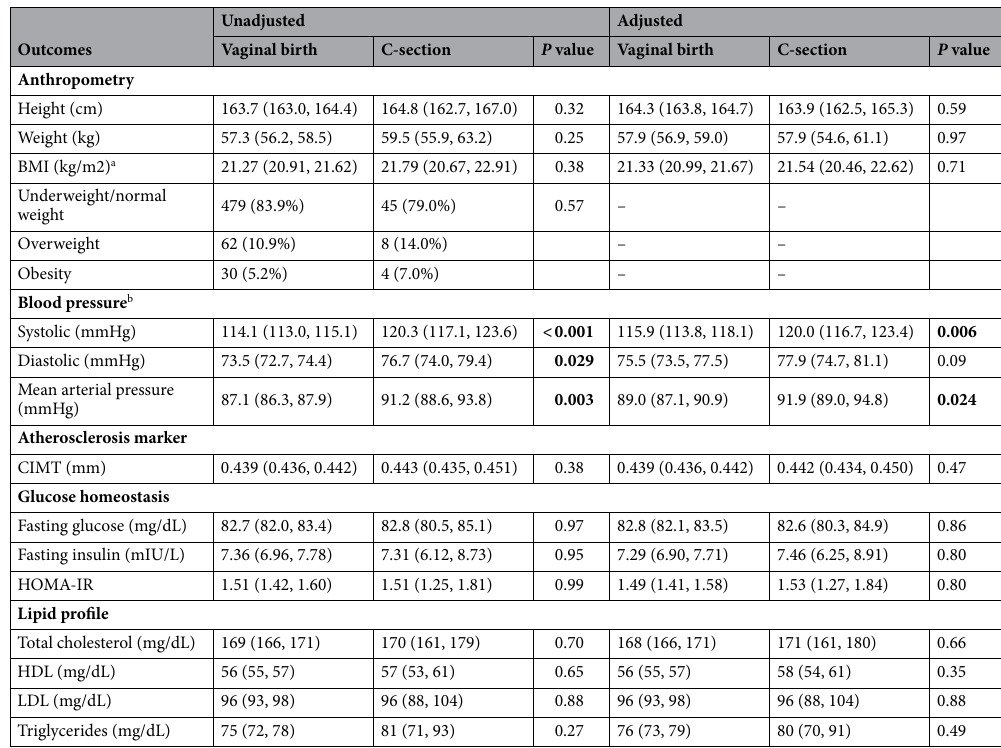
Table 3. Anthropometric and cardiometabolic outcomes in a cohort of young adults in Chiang Mai (Thailand) according to delivery mode. Underweight/normal weight was defined as BMI < 25 kg/m 2 , overweight as BMI ≥ 25 but < 30 kg/m 2 , and obesity as BMI ≥ 30 kg/m 2 . BMI status data are n (%); all other data are means, and the respective 95% confidence intervals (CI). Adjusted means are the least-squares means and respective 95% CI, adjusted for sex and gestational age at delivery, as well as: maternal height for offspring height; maternal BMI and offspring height for offspring weight; maternal BMI for offspring BMI; and mother’s pregnancy-induced hypertension (yes vs no) for offspring BP. BMI body mass index, CIMT carotid intima-media thickness, C-section caesarean section, HDL high-density lipoprotein cholesterol, HOMA-IR homeostatic model assessment of insulin resistance, LDL low-density lipoprotein cholesterol, RR relative risk. P values that are statistically significant (at p < 0.05) are shown in bold. a BMI data were not available for four participants born vaginally. b Systolic and diastolic BP data were missing for 12 and 6 participants born vaginally, respectively, and for one participant born by